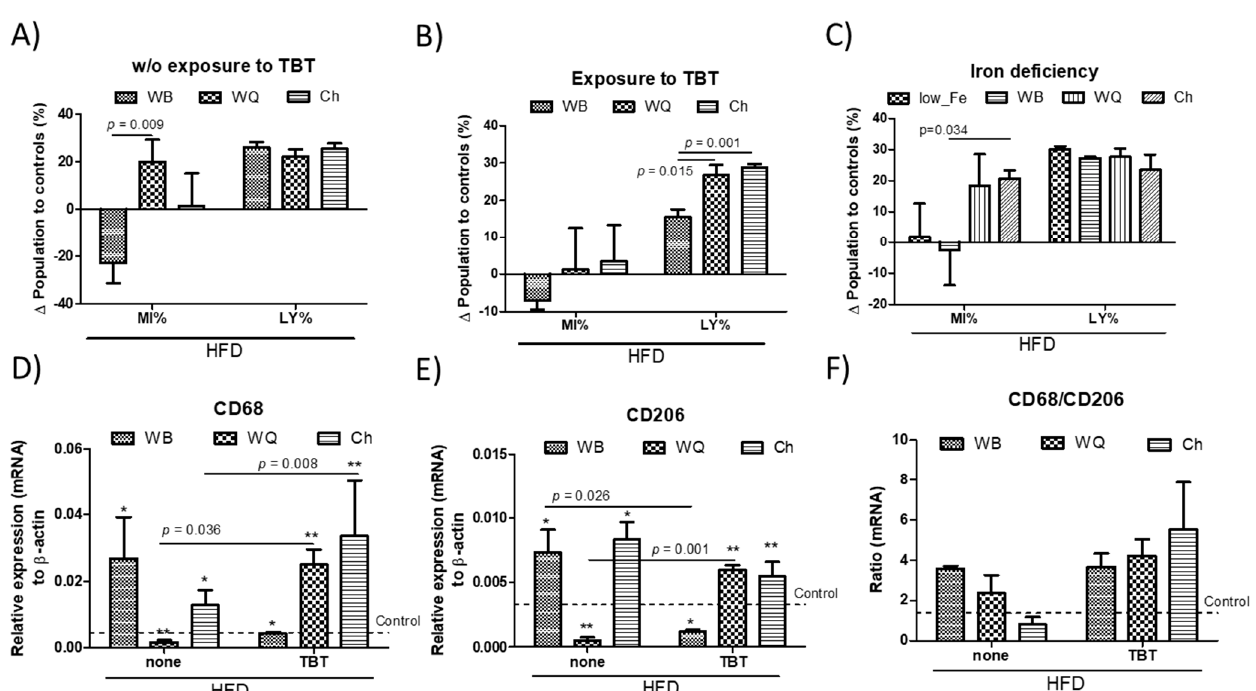
Figure 5. Peripheral relative variations of myeloid (MY) and lymphoid (LY) populations in wild type ( A ) and tributyltin (TBT)-exposed mice ( B ) as well as in iron-deficient ( C ) animals. Hepatic rt-qPCR analysis (mRNA) of selected macrophage marker genes; CD68 ( D ), CD206 ( E ) and their relative variation ( F ). Animals were fed with different bread formulations-WB, wheat bread; WQ, white quinoa flour (25%)–containing bread; Ch, chia flour (20%)–containing bread. Results are expressed as mean ± mean standard error ( n = 6). Untreated controls are represented by the dotted line. *,** indicates statistical differences between animals put under the same experimental model.